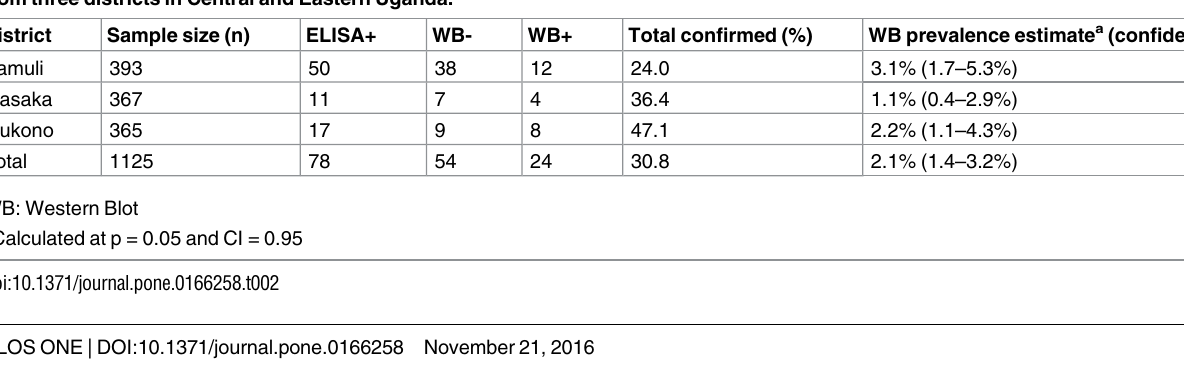
Table 2. Western Blot (WB) confirmation of ELISA positive samples (anti- Trichinella IgG), collected between April and July 2013 in 22 villages from three districts in Central and Eastern Uganda. District Sample size (n)